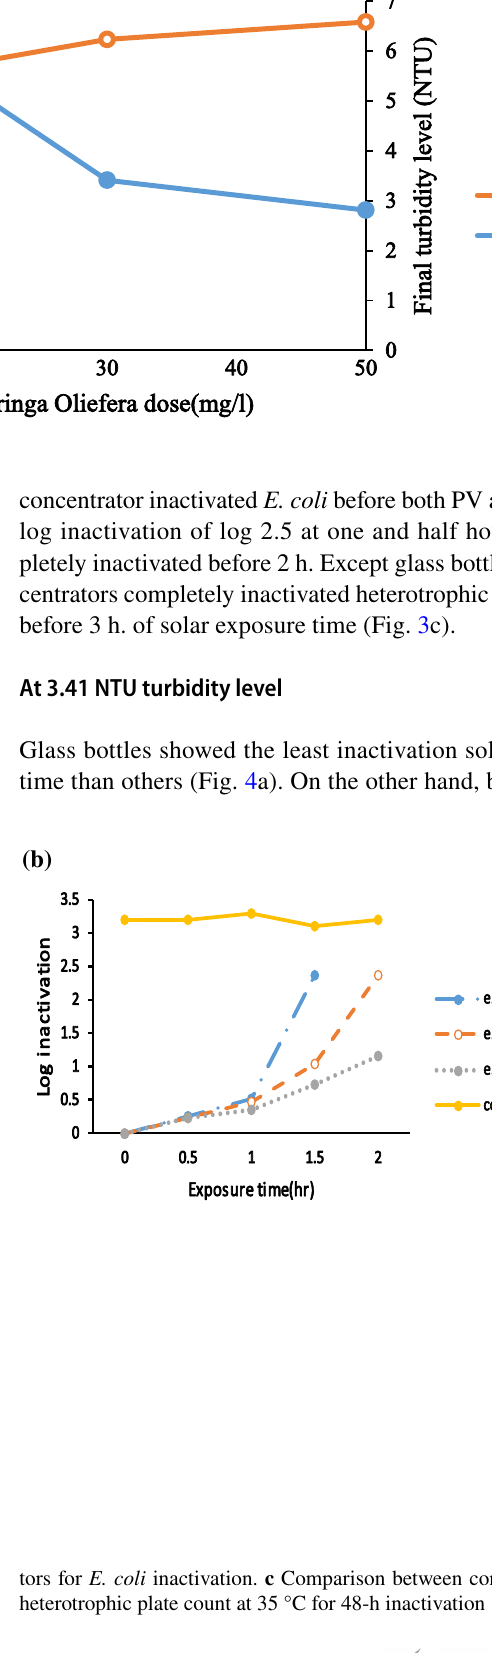
Fig. 2 Moringa oleifera turbid-